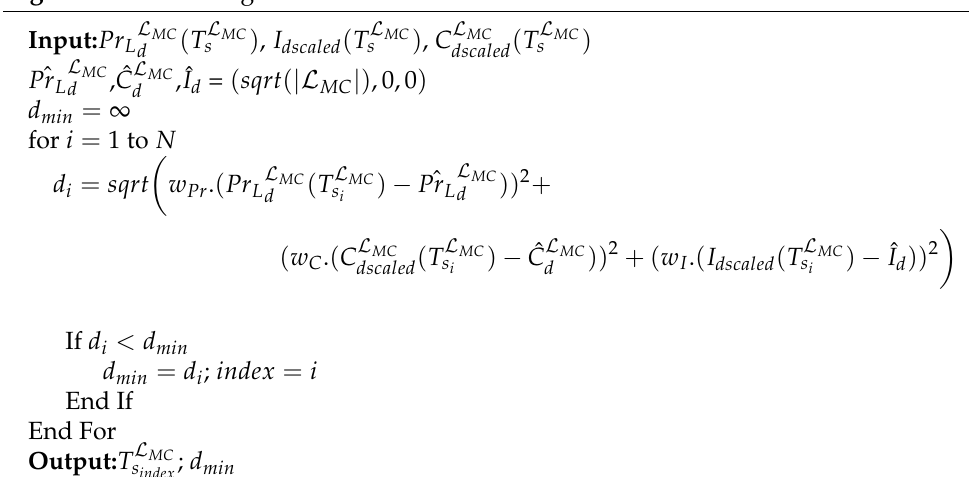
Algorithm 2 BFCP Algorithm of